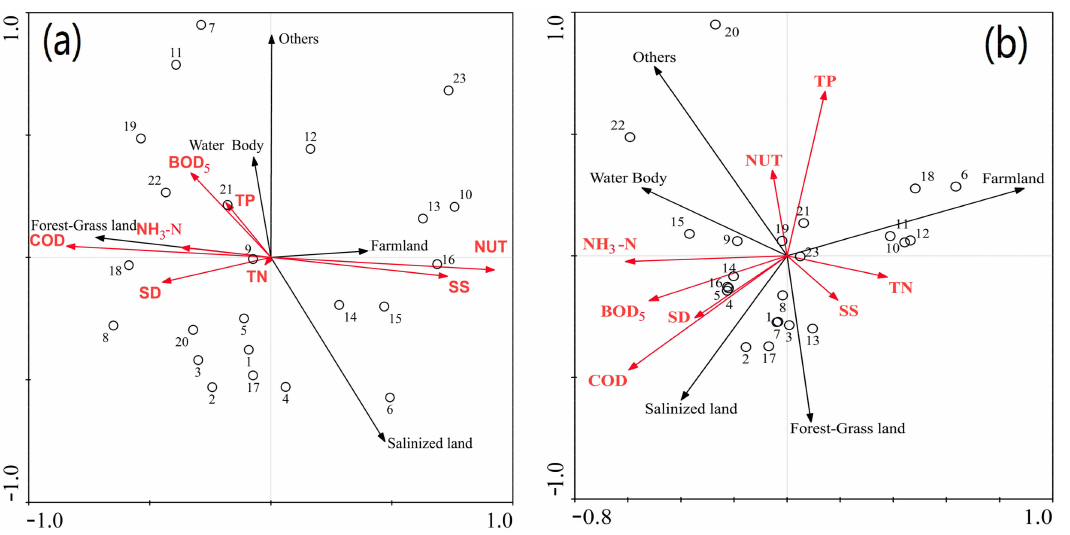
Figure 8. Redundancy analyses (RDA) of comprehensive land use/cover and water quality ( a ) wet season; ( b ) dry